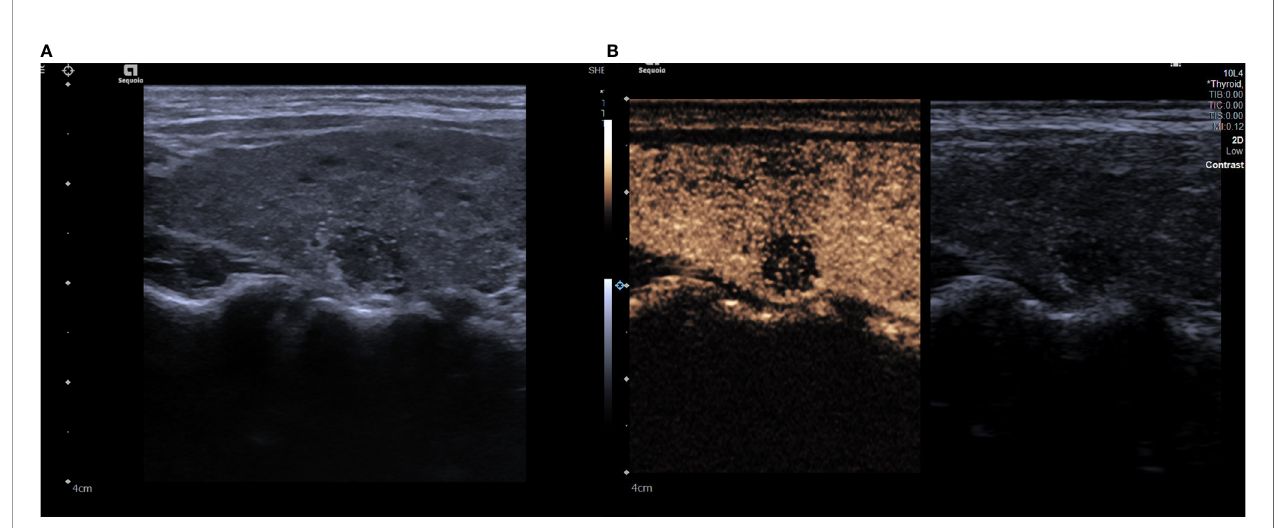
FIGURE 1 | (A) A grayscale ultrasound image. We found a 9 x9mm solid hypoechoic nodule in the right lobe of a patient ’ s thyroid, this nodule has faint borders, irregular margin and microcalci fi cations inside. (B) A contrast ultrasound image, the nodule shown has low enhancement. The degree of malignancy risk of the nodule is classi fi ed as grade 5.